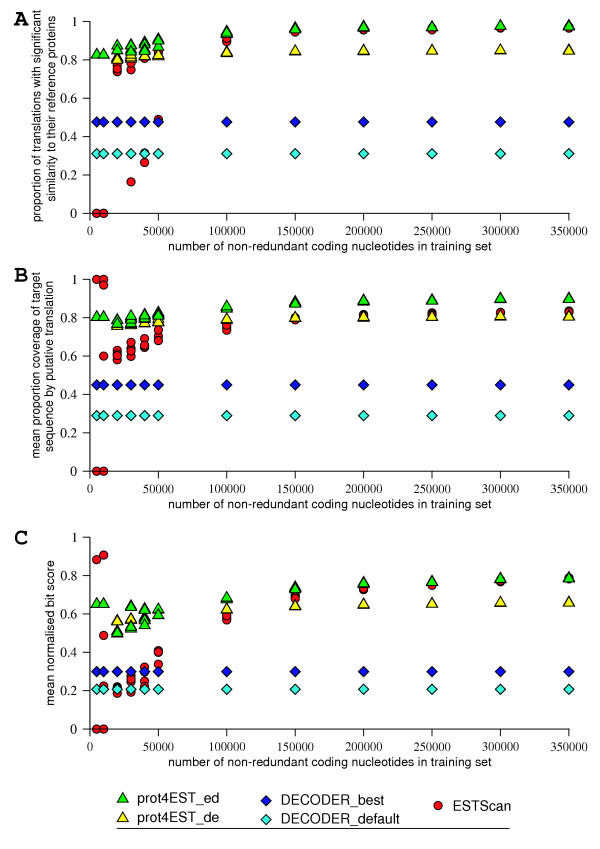
Performance of polypeptide prediction methods under different training regimes. Predicted polypeptides were compared to their reference. Four independent replicates of each training set size were used. a) Proportion of predicted polypeptide peptides having a significant BLASTP match to their reference protein. b) The mean proportion of each sequence covered by a predicted polypeptide. c) The mean relative bit score of each predicted polypeptide compared to its reference protein. The scores in b) and c) are the mean of the sequences translated by each method. The high scores shown by ESTScan at 5000 and 10000 non-redundant coding nucleotides is due to the method returning at most one polypeptide out of the 2316 nucleotides provided.